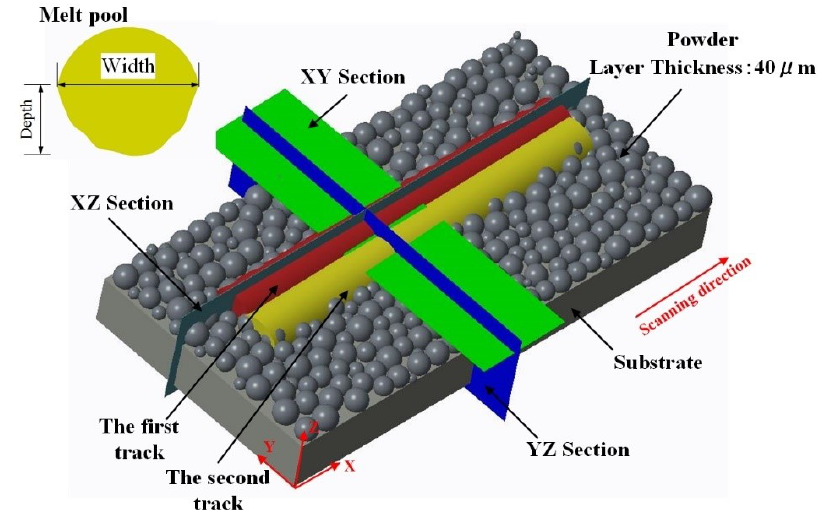
Figure 4. Simulation analysis model including powder layer, substrate, melt tracks and their laser scanning direction, different cross-sections, and melt pool geometries (depth and width).